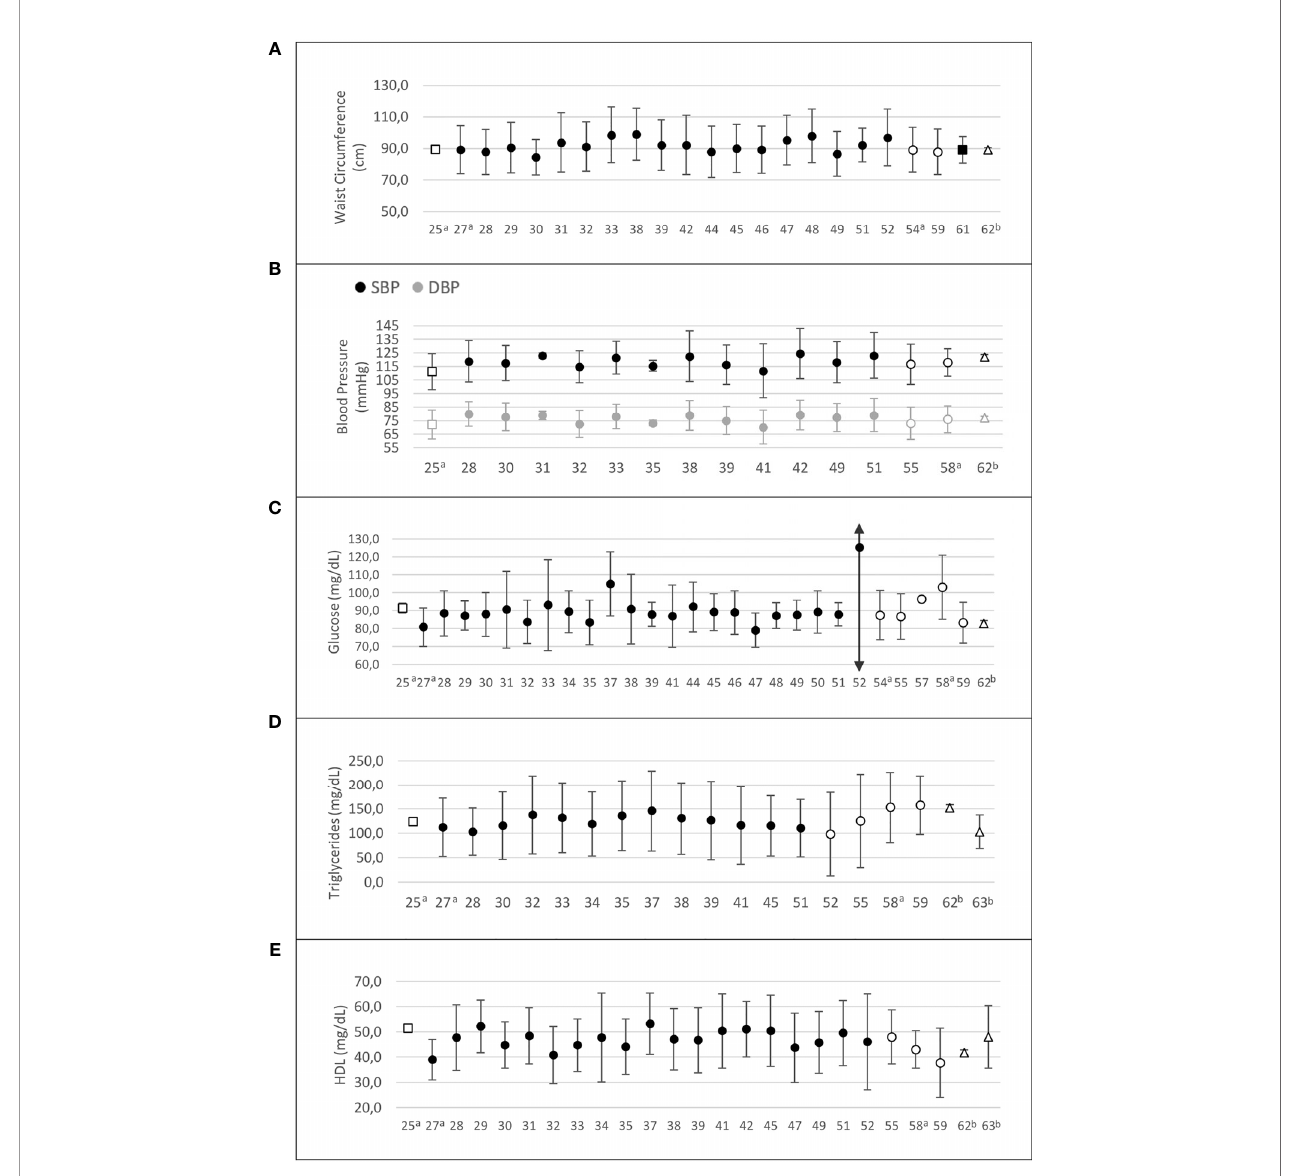
FIGURE 4 | Risk factors composing the metabolic syndrome in Latin American women with PCOS. (A) Waist circumference (cm); (B) systolic and diastolic blood pressure (mm Hg); (C) fasting glucose (mg/dL); (D) triglycerides (mg/dL); (E) HDL-cholesterol (mg/dL). Values are expressed as mean and standard deviation. The “ x ” axis shows the reference number of studies (refer to the text). □ Argentina; (cid:129) Brazil; ○ Chile; Δ Venezuela. a PCOS diagnosis according to NIH criteria; b PCOS diagnosis de fi ned by the